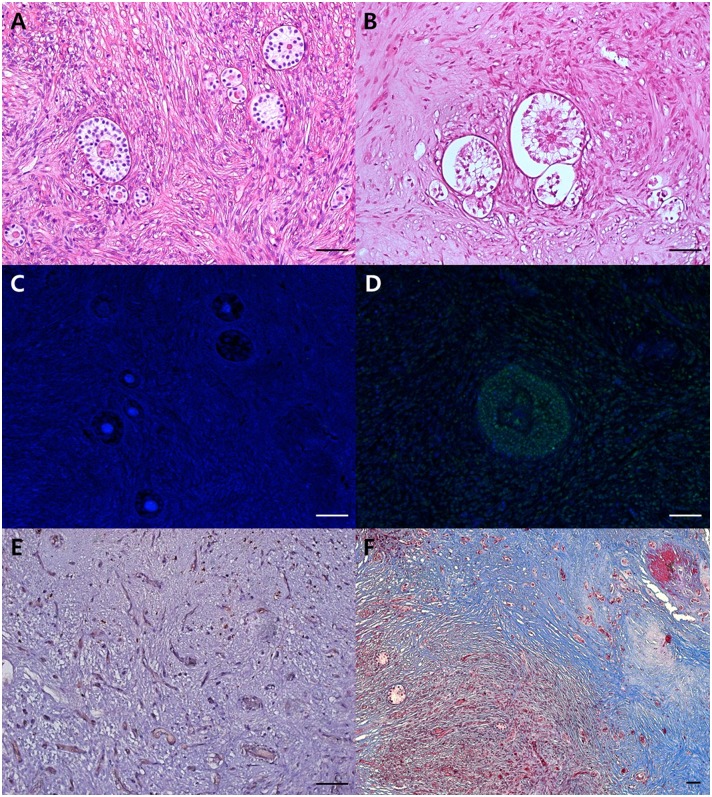
Representative images of ovarian grafts.Each panel shows (A) H&E-stained graft with morphologically normal follicles, (B) H&E-stained graft with morphologically abnormal follicles (follicle shrinkage and rupture, oocyte rupture), (C) TUNEL-stained graft with non-apoptotic follicle (blue), (D) TUNEL-stained graft with apoptotic follicle (green), (E) CD31-immunostained microvessels (brown), and (F) Masson’s trichrome-stained graft (red: cytoplasm, blue: fibrotic area, black: nuclei). Scale bar: 100 μm.